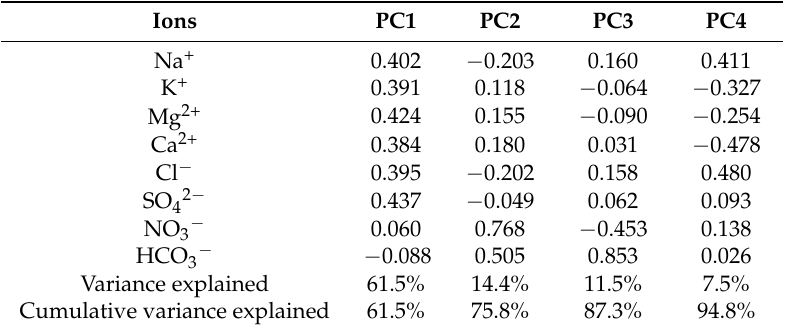
Table 2. PCA loadings in different ions and variances explained by different